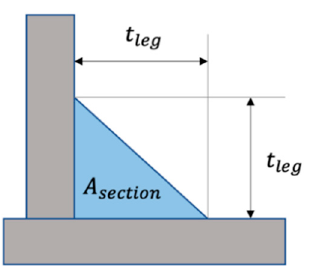
Figure A1. Welding section area expressed by leg length.